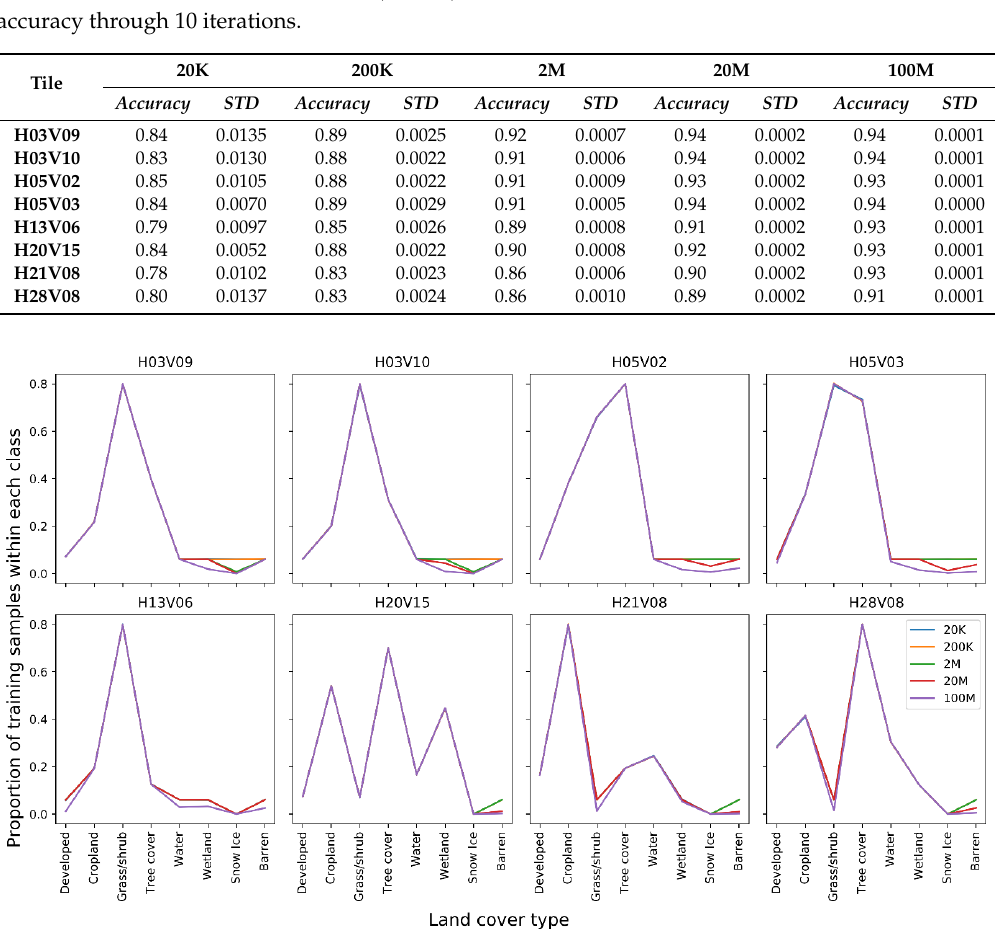
Figure 3. The pixel distribution of each class in comparative relation to the class upper limits (8000, 80,000, 800,000, 8,000,000, and 40,000,000, respectively) for a total of 20K, 200K, 2M, 20M, and 100M stratified training